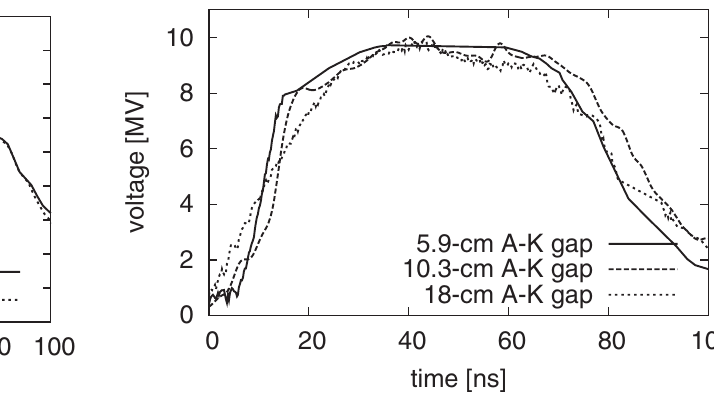
FIG. 5. Voltages at diagnostic position E calculated from mea- sured currents for large-area-diode loads with A-K gaps of 5.9, 10.3, and 18.1 cm on the straight MITL (RITS-6 shots 14, 17, and 19, respectively).